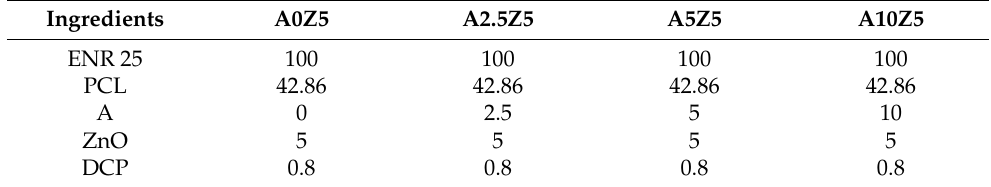
Table 2. Rubber recipes of TPEs reinforced with different contents of A and 5 phr of ZnO (in phr).